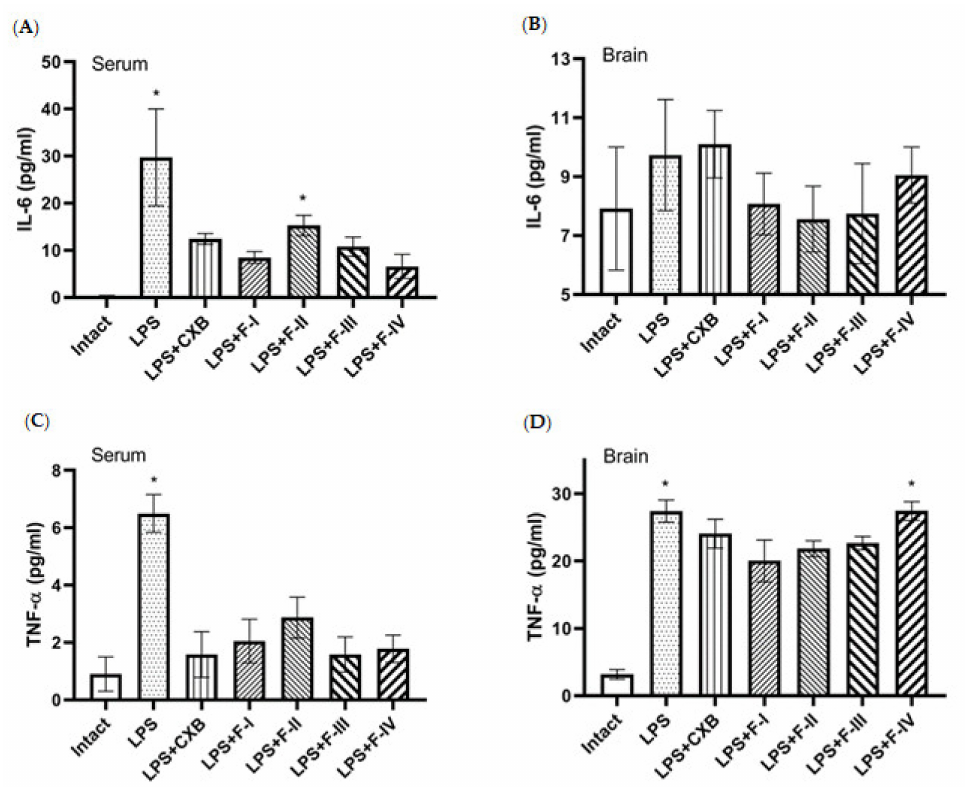
Figure 1. IL-6 and TNF- α levels 72 h after LPS injection in mice in serum (panels ( A , C )) and in brain (panels ( B , D )); * p < 0.05 statistically significant when compared with intact group; CXB—celecoxib;